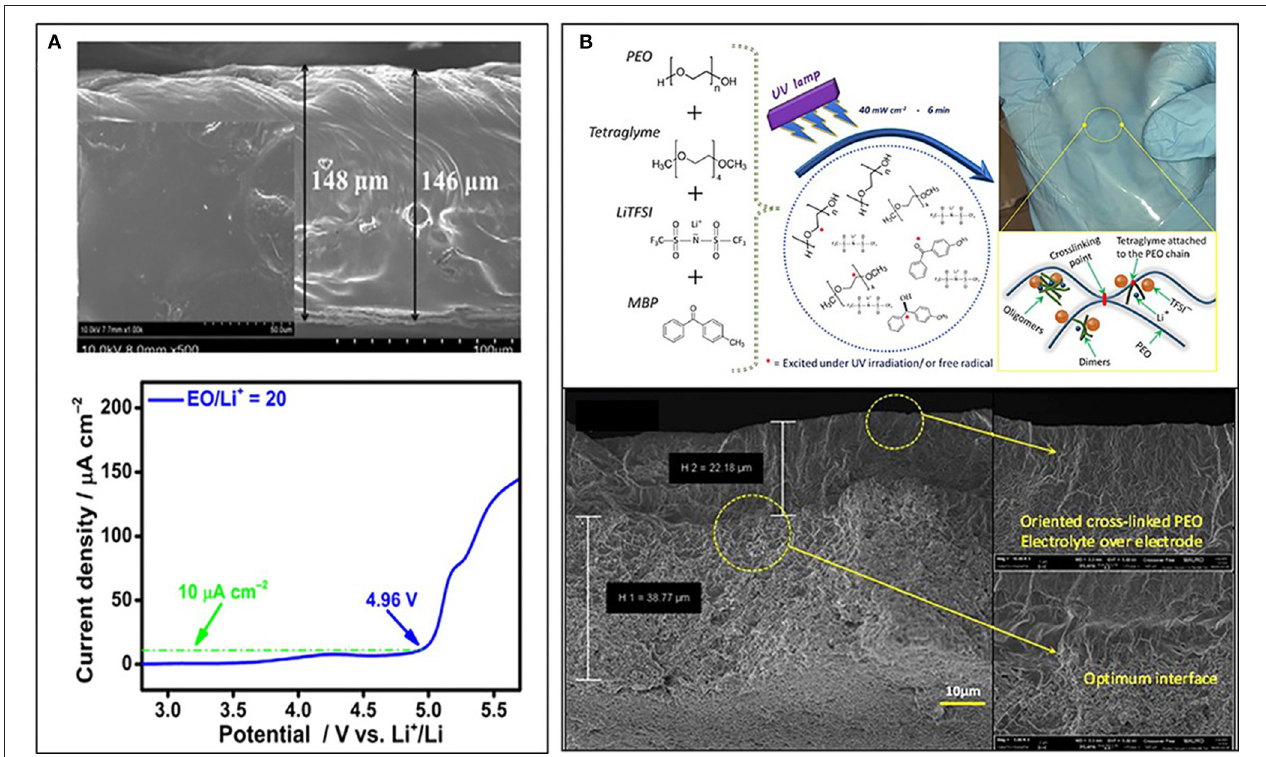
FIGURE 3 | (A) SEM image (up) and linear sweep voltammogram (down) for the membrane of the LiTNFSI/PEO (EO/Li + = 20) blended polymer electrolyte. [Reprinted with permission from ( Ma et al., 2016b). Copyright (2016) American Chemical Society]. (B) Interconnected PEO chains with hypothesized branched clusters of tetraglyme oligomers (top left) and the real aspect of a freshly prepared ISPE (top right); Cross-sectional FESEM images showing the optimum interface achieved after UV curing (down). [Reprinted with permission from ( Porcarelli et al., 2016). Copyright (2016) Nature].